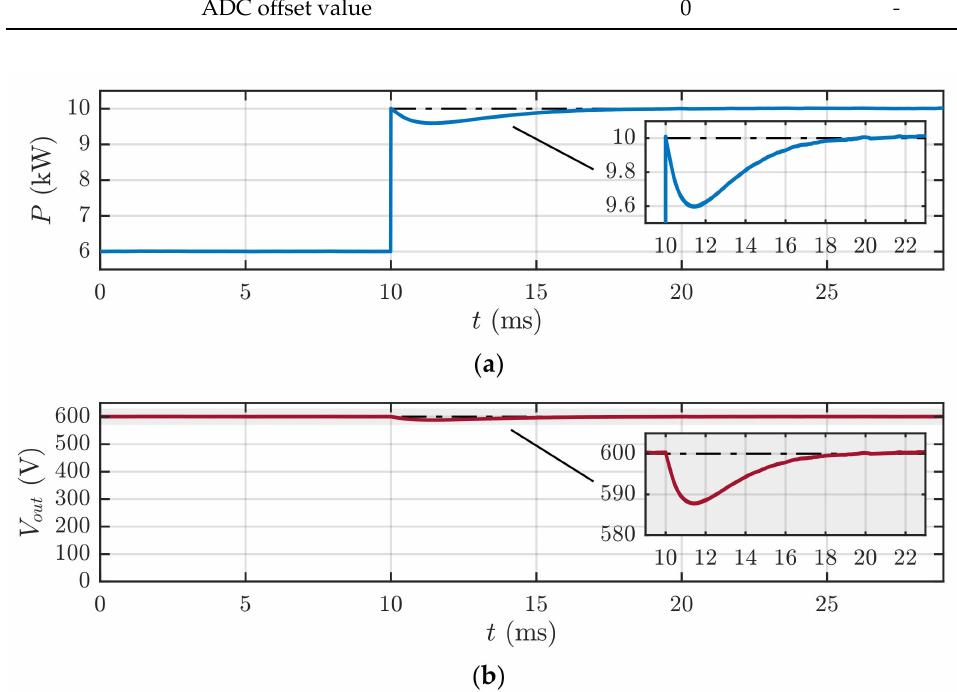
Figure 18. Real-Time HIL results ( a ) output power, ( b ) output voltage during load variation from 6 kW to 10 kW with the proposed control